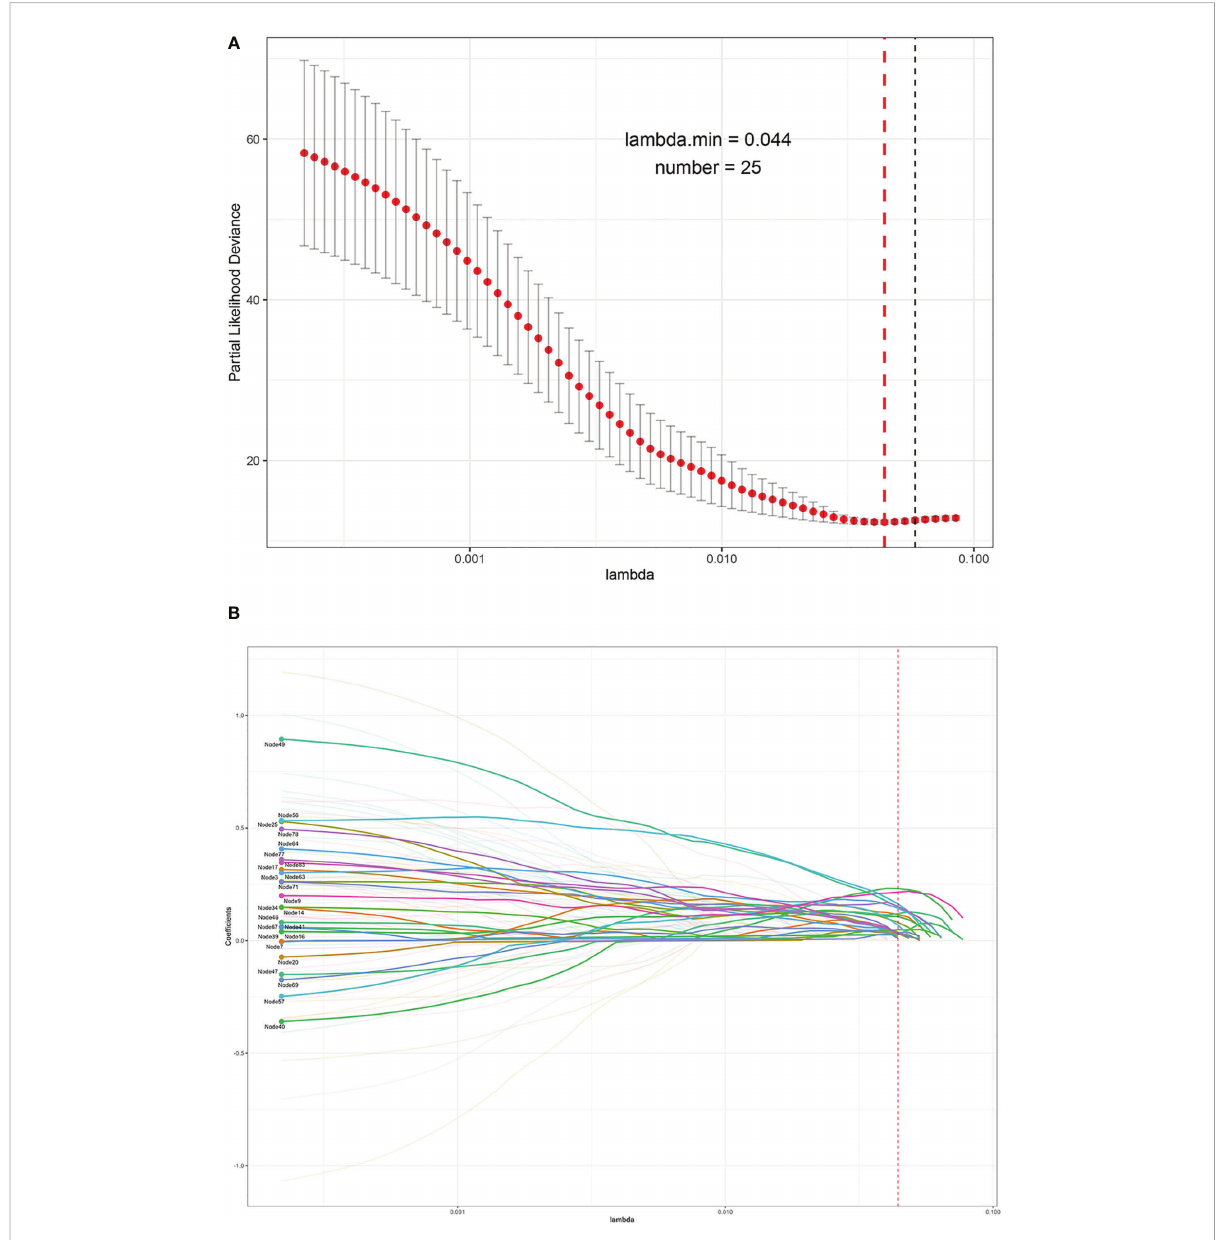
FIGURE 2 The process of the LASSO to select optimal predictors in BRCA data. (A) Penalty parameter tuning conducted by 10-fold cross-validation. (B) The solution pathway of the 25